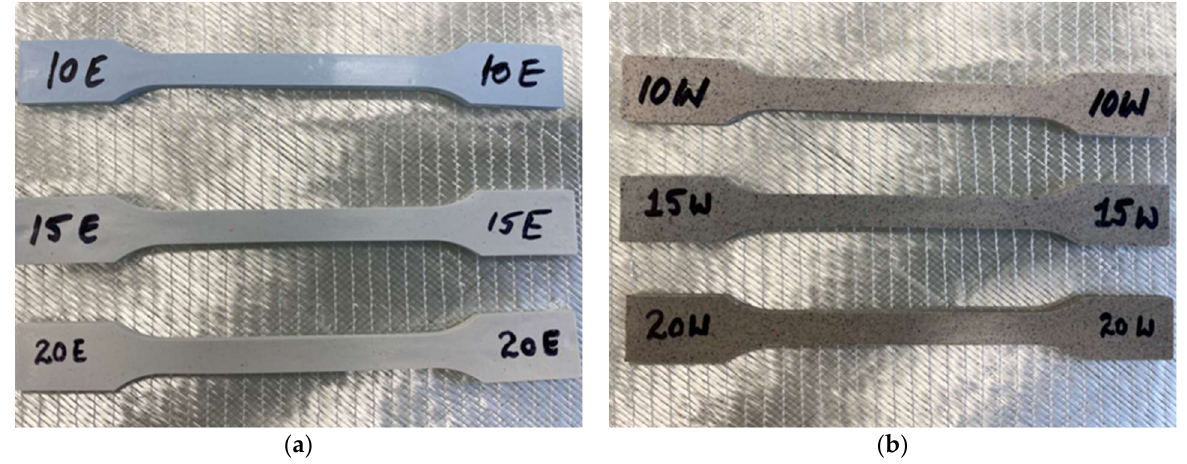
Figure 2. Injection molded dog bone-shaped specimens of: ( a ) PLA–ES composites; ( b ) PLA–WS composites.